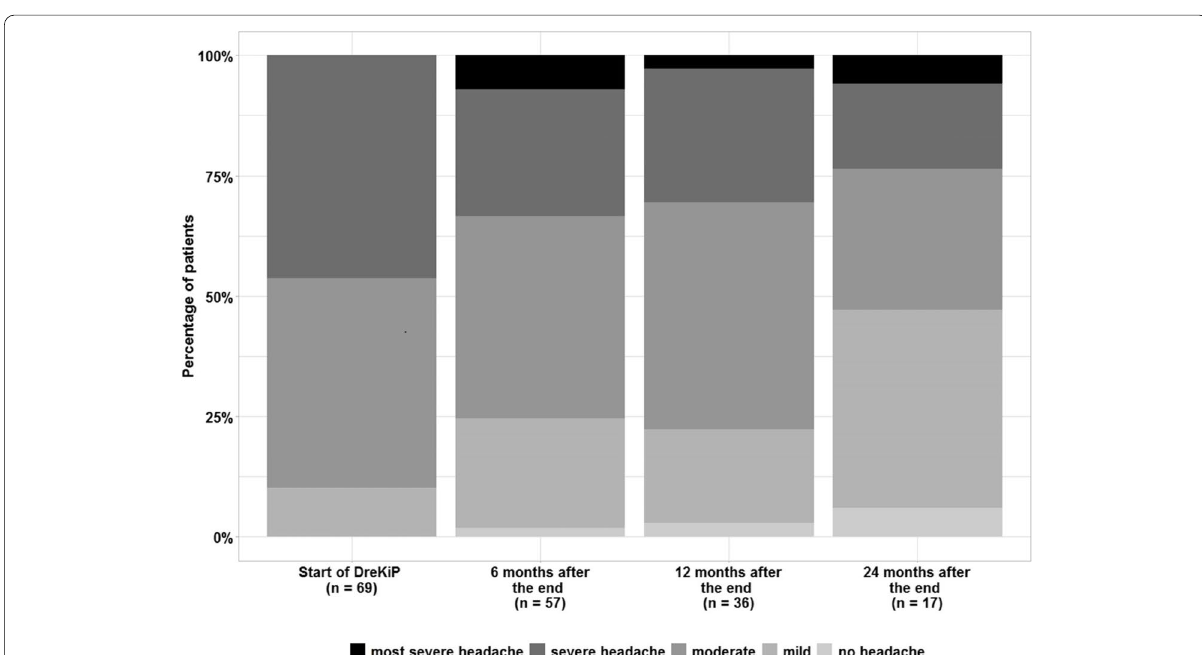
Fig. 4 Headache intensity. (proportion of patients with headache intensity classified as “most severe”, “severe”, “moderate”, “mild” and “no headache” in the last 3 months) at baseline and follow up 6, 12 and 24 months after the program “DreKiP” (stands for Dresden children and adolescent headache program)